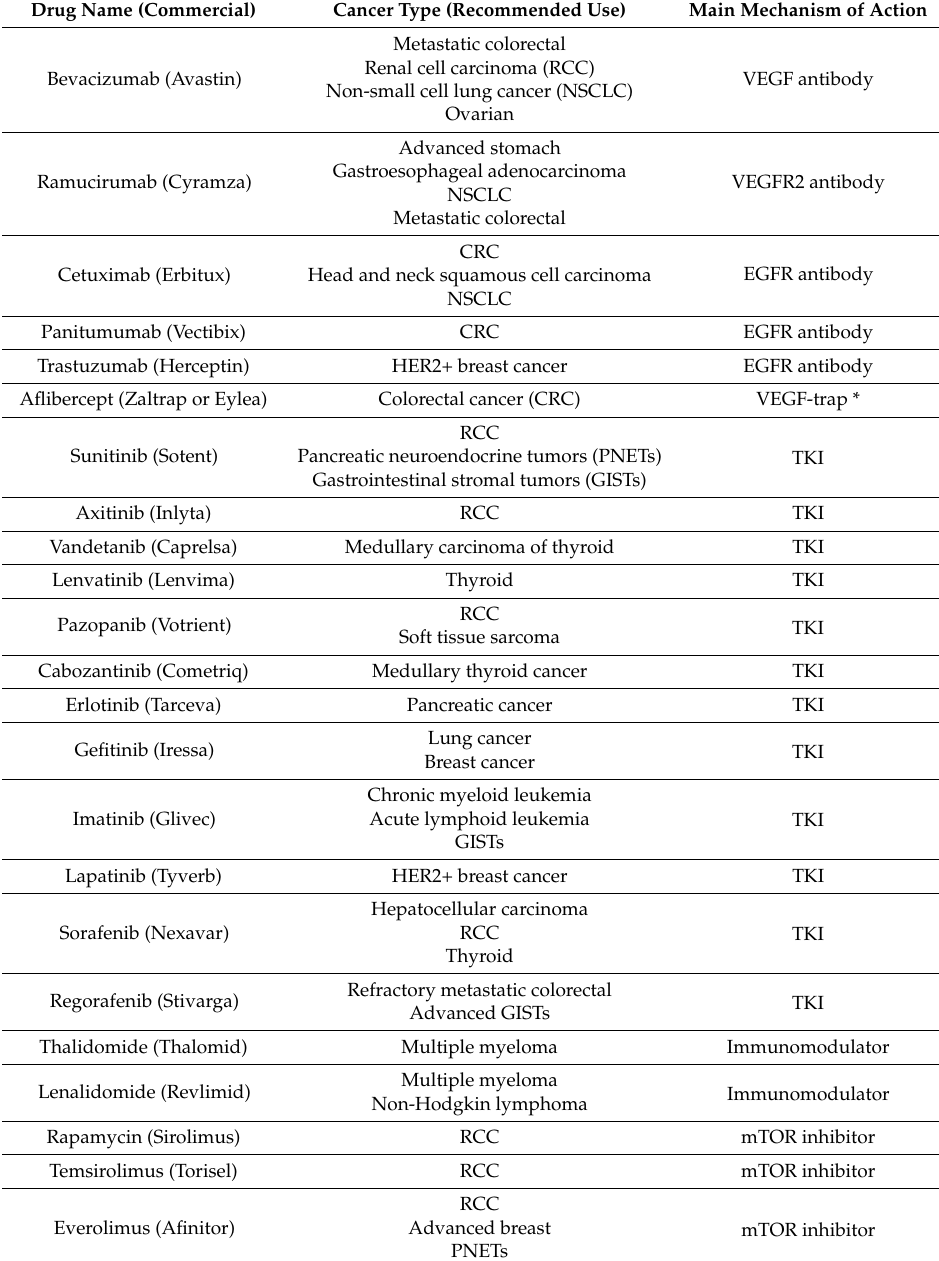
Antiangiogenic compounds currently approved by the USA Food and Drug Administration